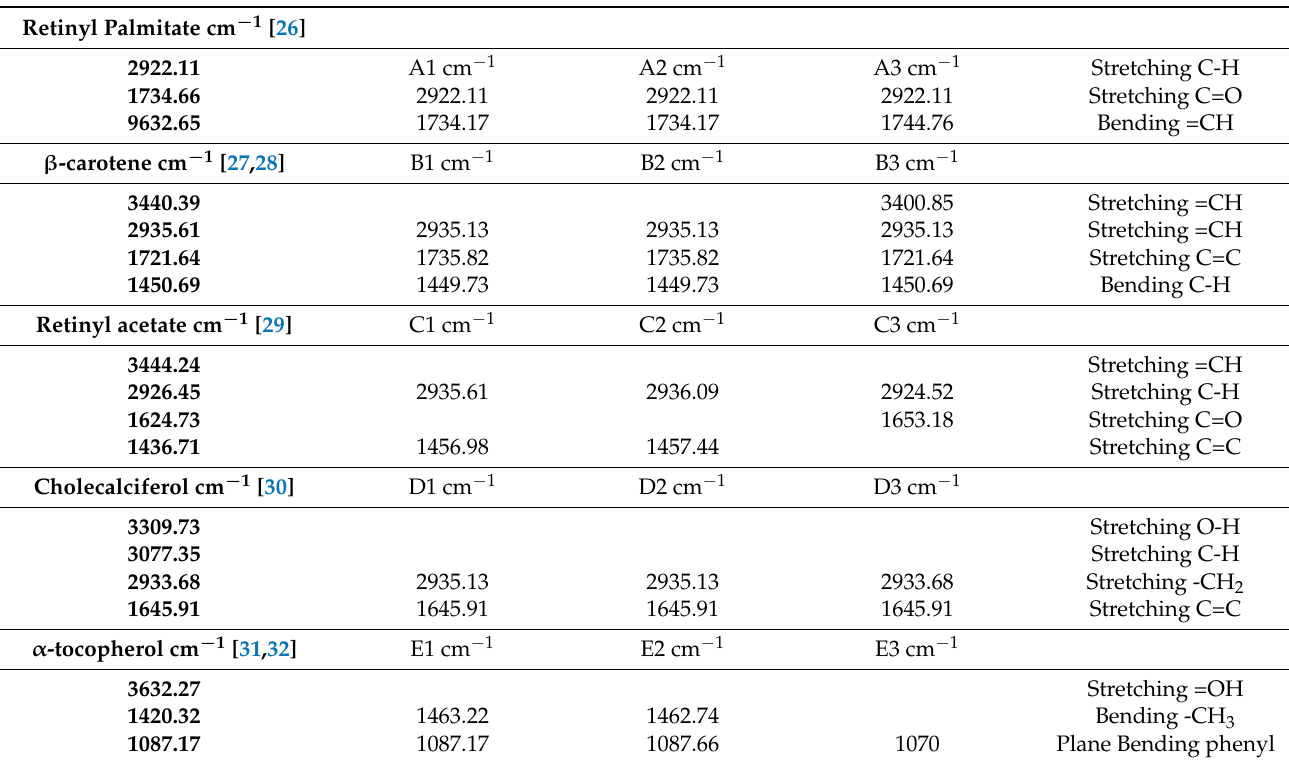
Table 3. FTIR peak assignment for each vitamin and MP batch: A1 (retinyl palmitate and Eudra- guard Biotic), A2 (retinyl palmitate and CAP), A3 (retinyl palmitate and WPs), B1 ( β -carotene and Eudraguard Biotic), B2 ( β -carotene and CAP), B3 ( β -carotene and WPs), C1 (retinyl acetate and Eudraguard Biotic), C2 (retinyl acetate and CAP), C3 (retinyl acetate and WPs), D1 (cholecalciferol and Eudraguard Biotic), D2 (cholecalciferol and CAP), D3 (cholecalciferol and WPs), E1 ( α -tocopherol and Eudraguard Biotic), E2 ( α -tocopherol and CAP), E3 ( α -tocopherol and